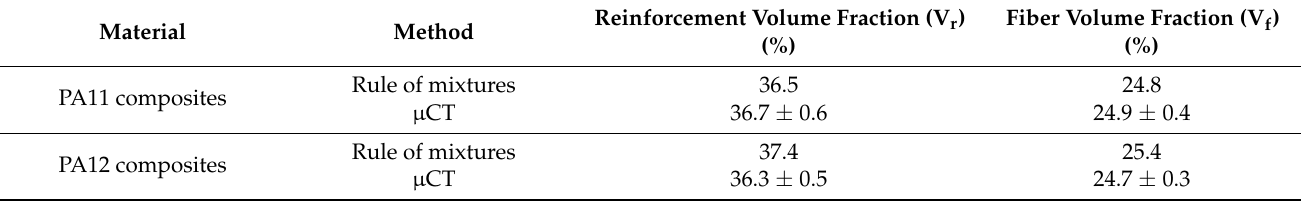
Table 4. V r and V f obtained by means of the rule of mixtures in composites and by the analysis of X-ray micro-computed